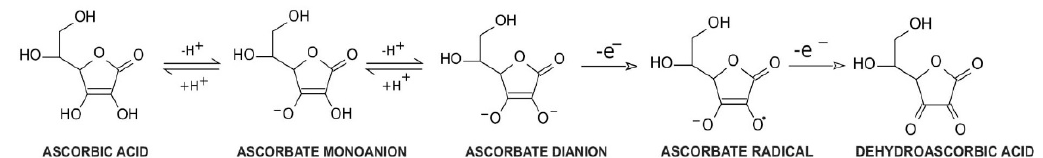
Figure 2. Vitamin C’s role in 2-oxoglutarate and Fe 2+ dependent dioxygenase (2-OGDD) activity. Legend abbreviations: ASc—ascorbate; SCVT1—sodium dependent vitamin C transporter 1;